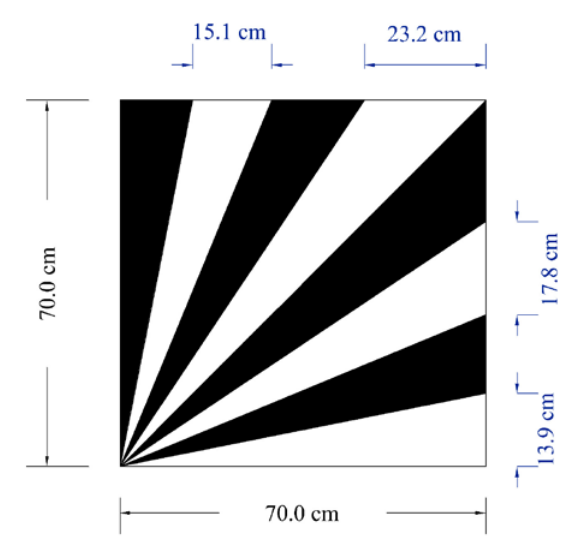
Figure 1. The project of the segment no 1: the quarter of Siemens star (diameter 70